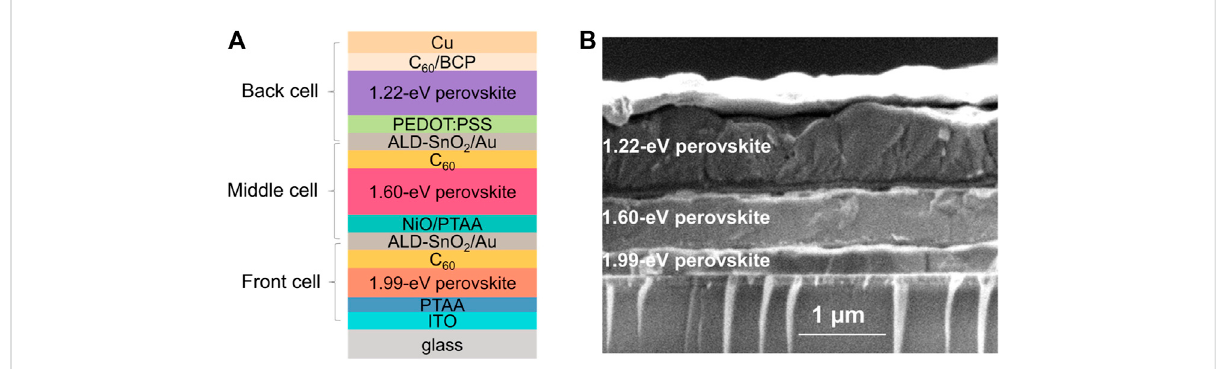
FIGURE 12 (A) Schematicsand (B) cross-sectionalscanningelectronmicrographof3-Jsolarcellwithperovskitematerialsforallabsorberlayers(Xiaoetal., 2020).